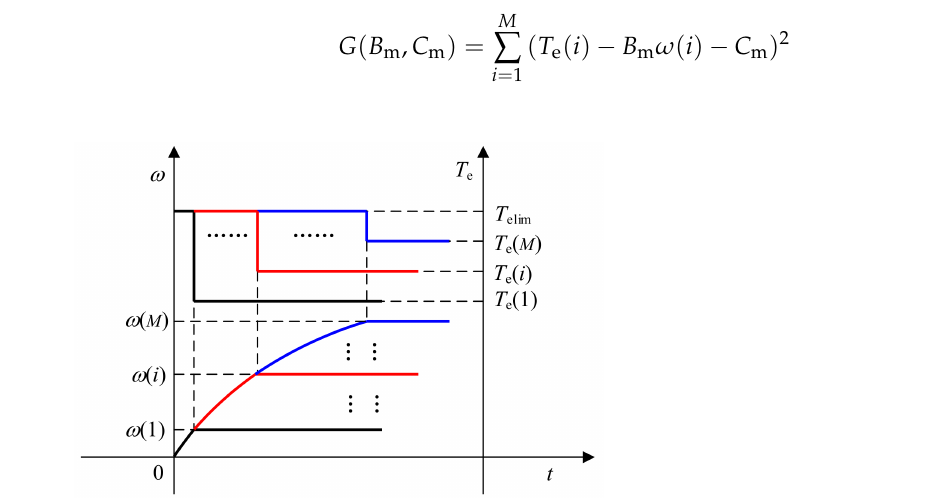
Figure 4. Diagram of torque and speed waveform in the measurement of viscous friction coefficient and Coulomb friction